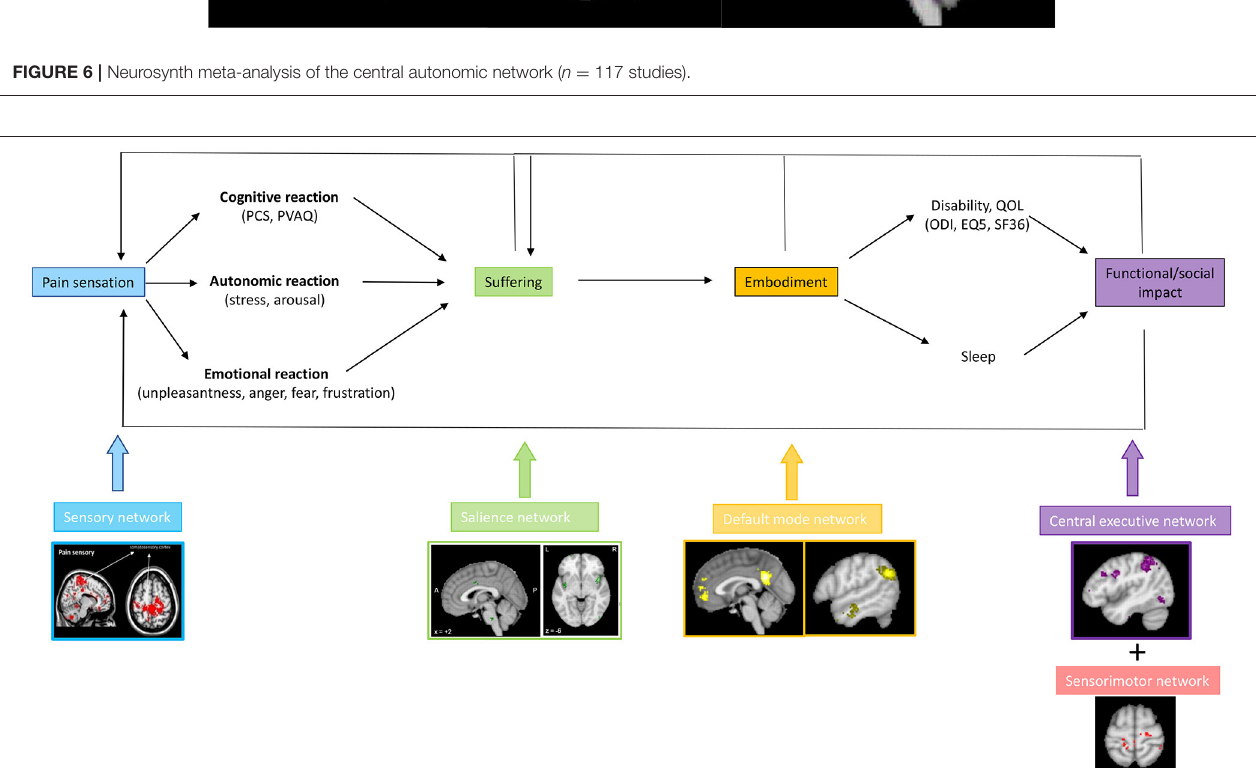
FIGURE 7 | The presence of a painful stimulus in the lateral somatosensory pathway, can lead to a cognitive, emotional, and autonomic response, encoded by the medial salience pathway expressed by suffering. When the pain and suffering become chronic, they become embodied, i.e., part of the self, mediated via connectivity of the somatosensory cortex to the default mode network. The embodied pain and suffering can subsequently lead to physical and cognitive disability, possibly mediated via dysfunctional connectivity with the motor and the central executive network,